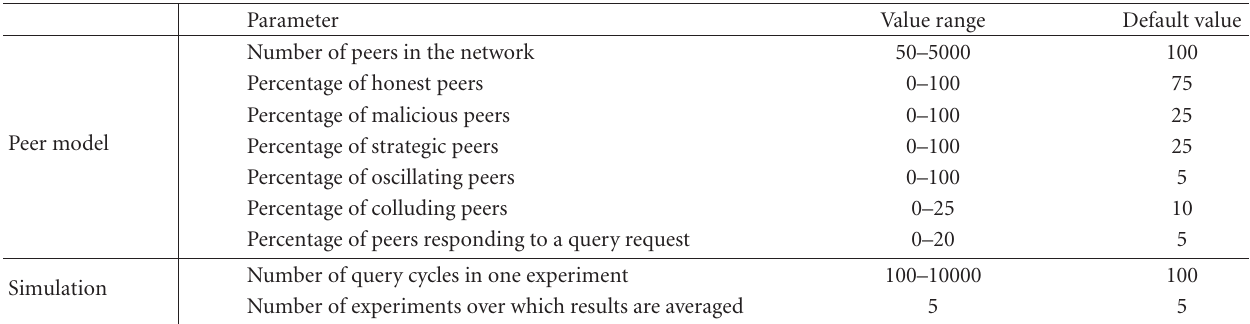
Table 1: Simulation